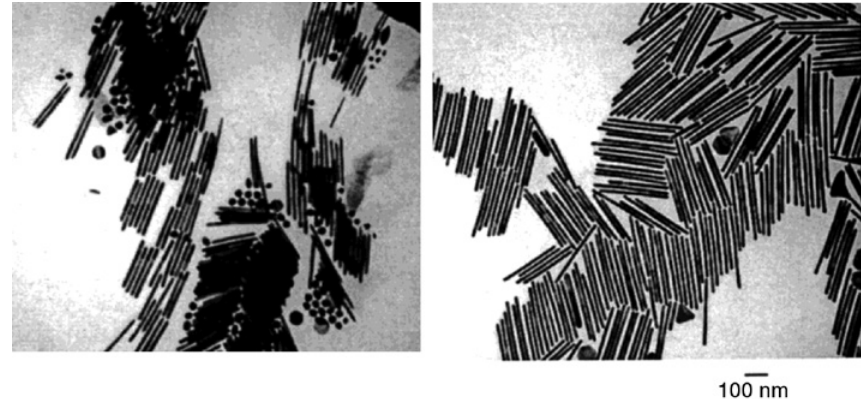
Figure 8: TEM picture of gold nanorods with various aspect ratios. Adapted with permission from Ref. [15]. Copyright (2015) American Chemical